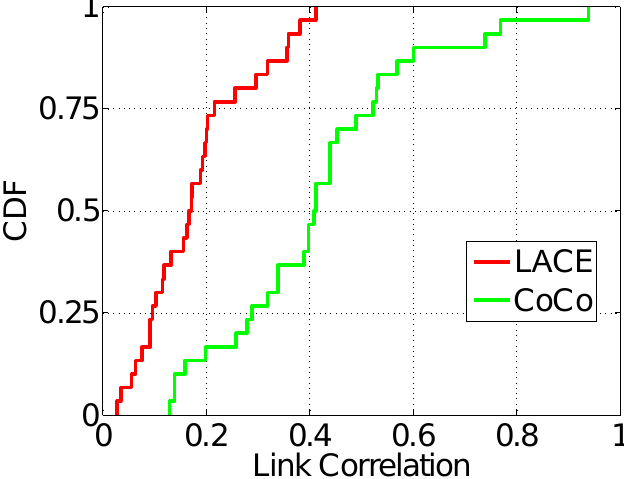
Figure 6. Estimation accuracy with CoCo [20].